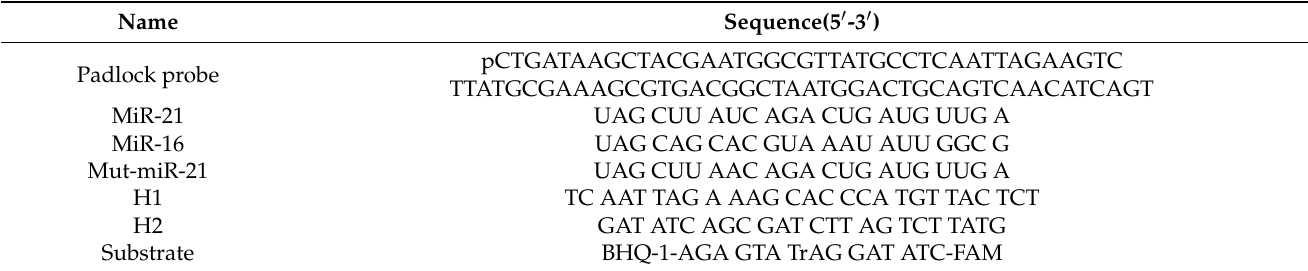
Table 1. Sequences of the oligonucleotides used in this